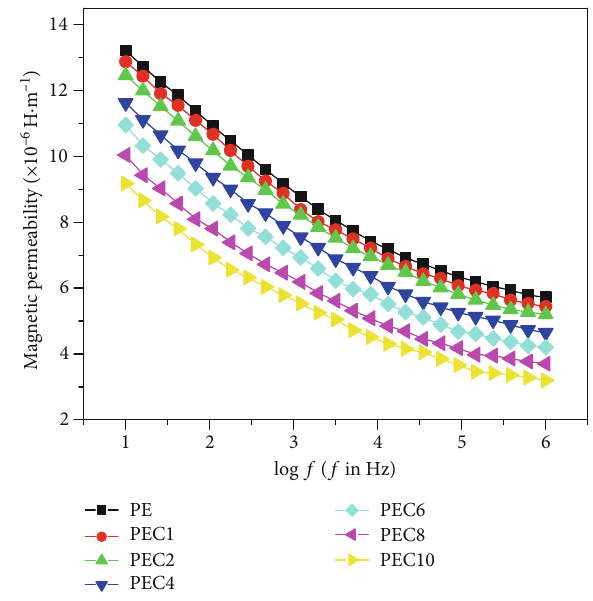
Figure 8: Plots of dielectric loss with respect to frequency for the composite system. Figure 9: Plots of magnetic permeability with respect to frequency for the selected composite